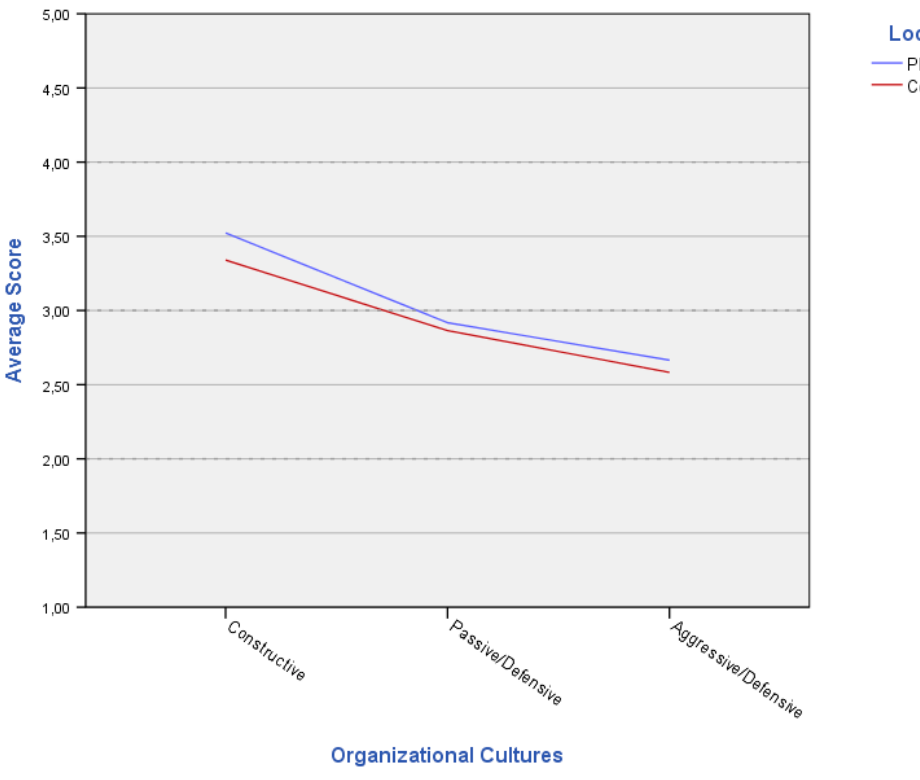
Figure 6. OCI organizational cultures averages by work location.